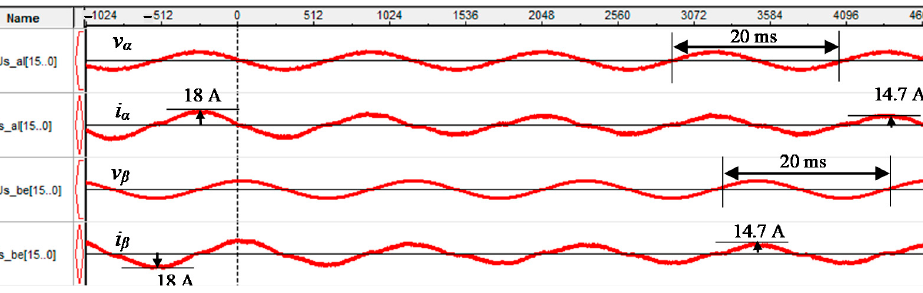
Figure 15. Change in reactive power character into the opposite one at constant active component 0.7 P N .